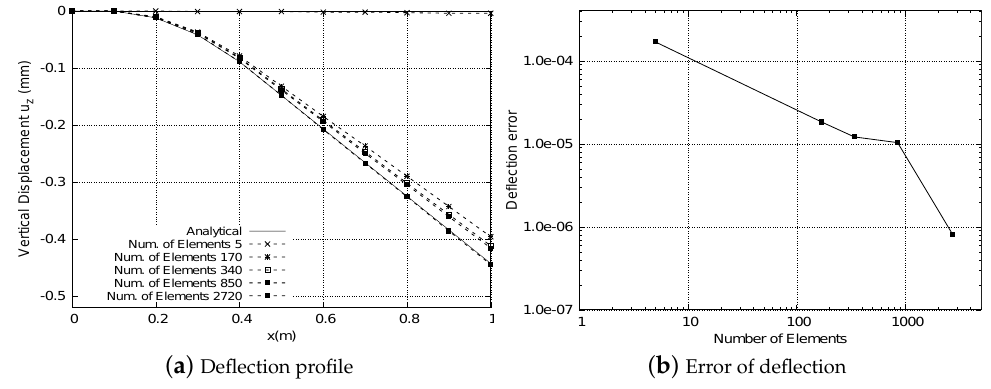
Figure 7. Comparison of FEM with analytical results for the three-layer beam case: ( a ) deflection profile along the beam span and ( b ) error of deflection for meshes with different numbers